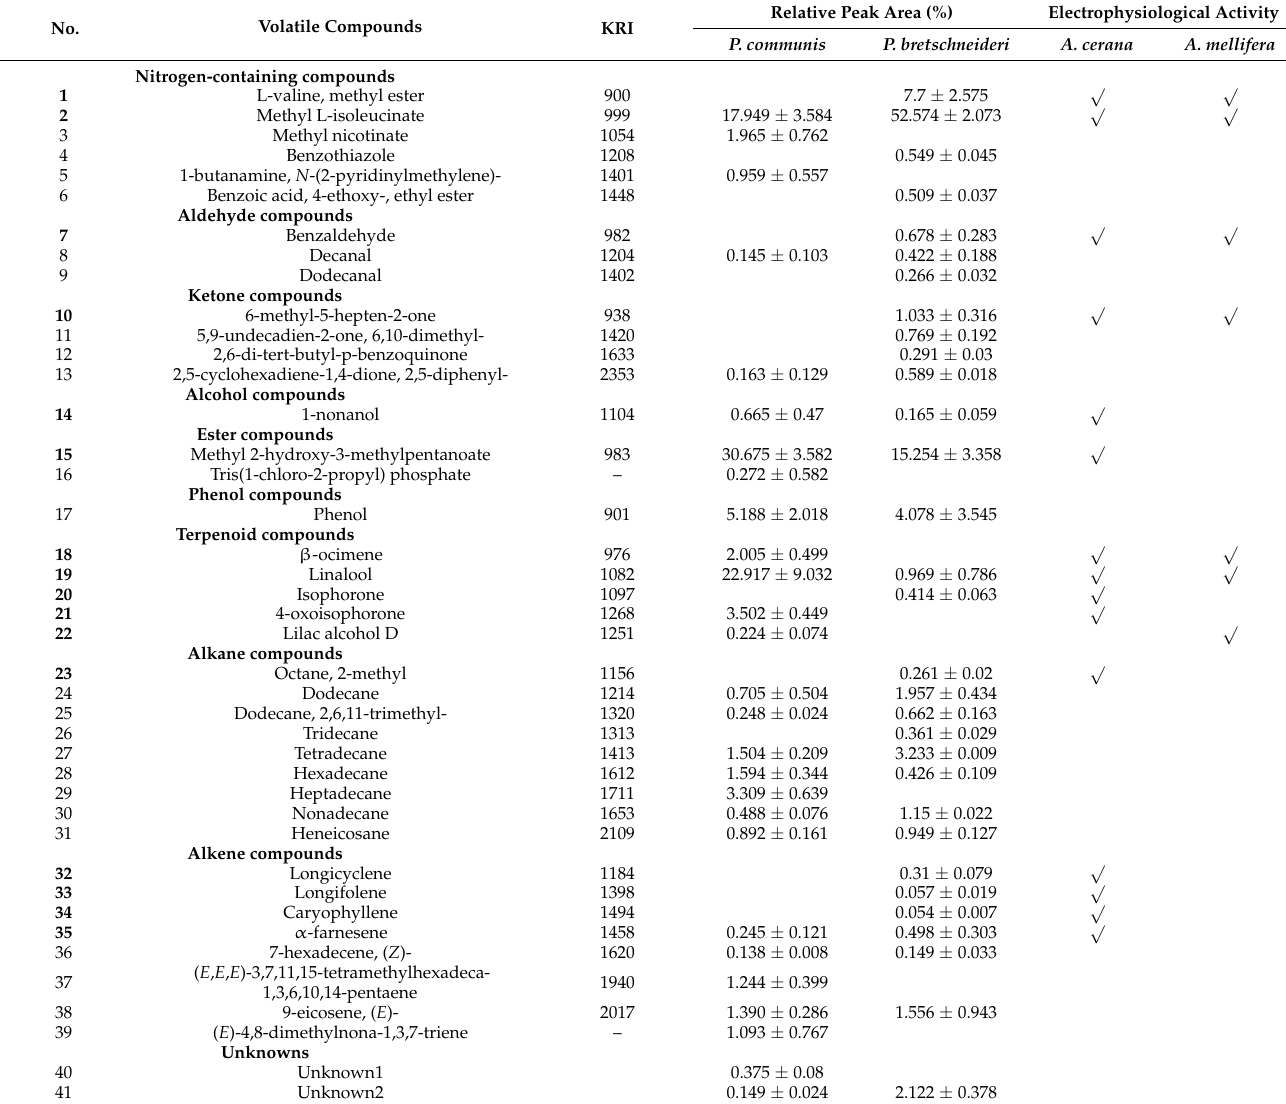
Table 2. Number and relative peak area (% of total for compound classes and single components) of volatiles detected in flower volatile samples of P. communis and P. bretschneideri and their electrophysi- ological activity in antennae of honey bees (antennae responding to a